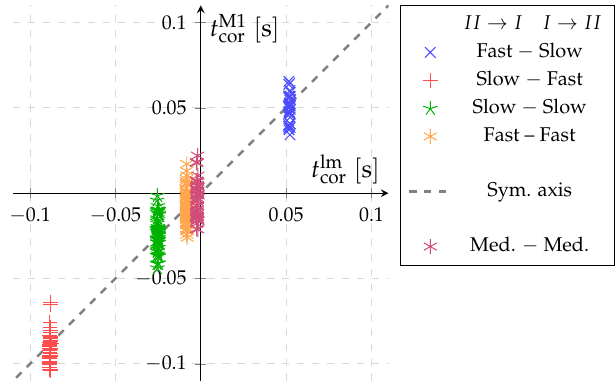
Figure 9. Comparison of the measurement results for the correction time according to Method 1 and the approximation model Equation (9) ( q m ≈ 9 mgmin − 1